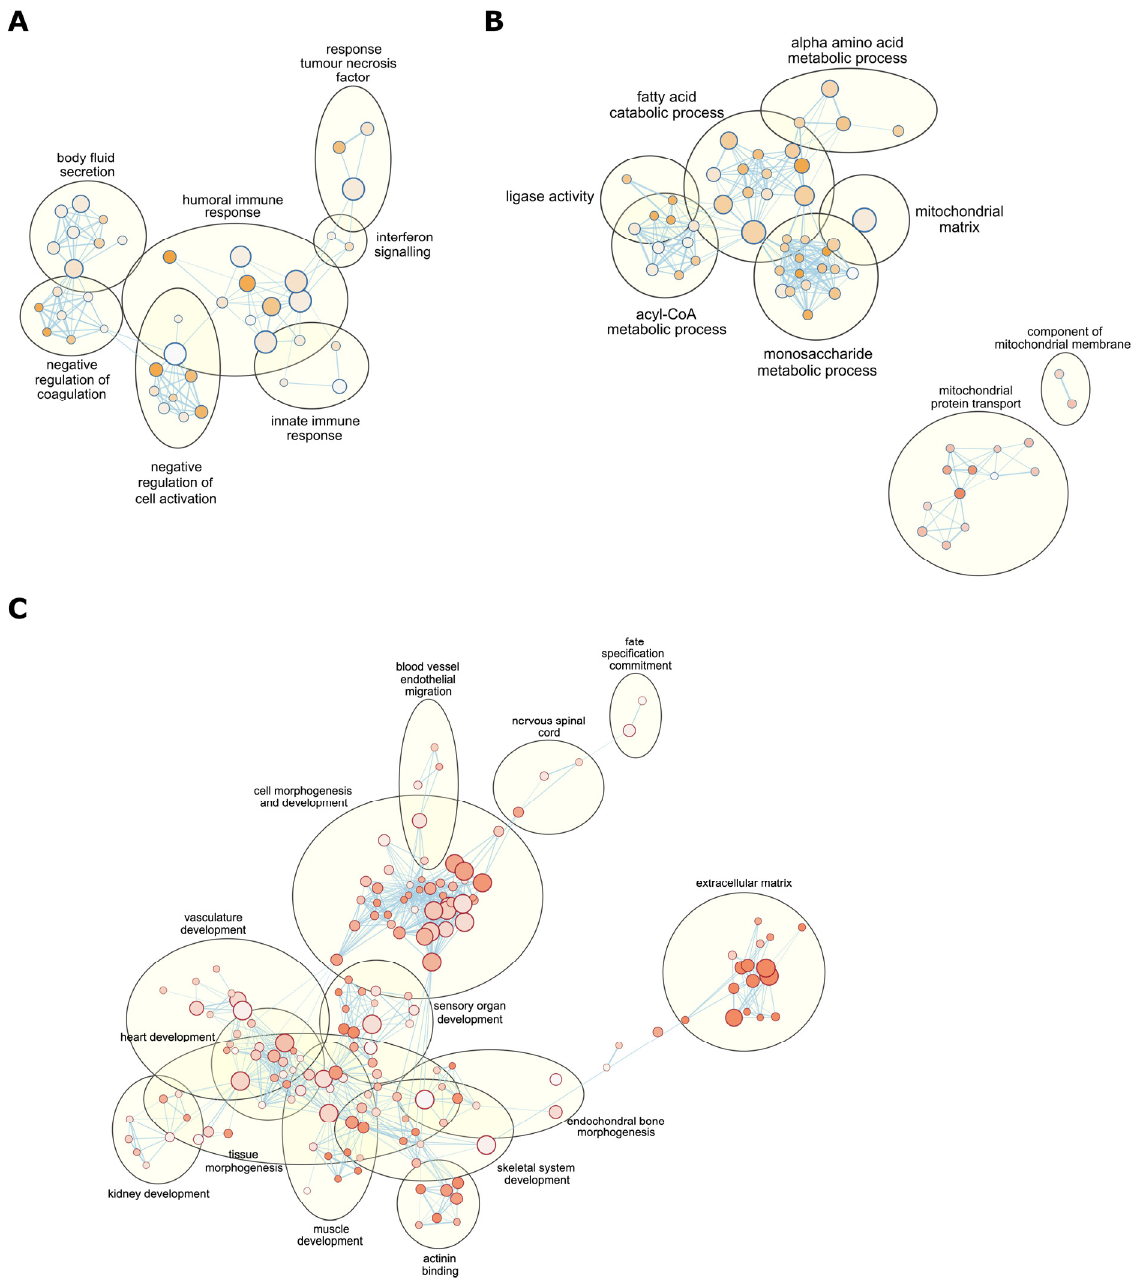
Figure 3. Functional pathway enrichment analysis displaying gene ontology (GO) biological process term networks. ( A ) The largest network associated with immune response, interferon signalling, and coagulation found in differentially expressed genes (DEGs) identified in brain tissue from mtDNA-supplemented and control pigs; ( B ) the largest network associated with fatty acid, acyl-CoA, monosaccharide metabolic processes (top) and mitochondrial protein transport related network (bottom) identified from heart DEGs between mtDNA-supplemented and control tissues; and ( C ) the largest network associated with morphogenesis and development for tissues and organs found in liver DEGs between mtDNA-supplemented and control tissues. GO terms with related function were grouped by Cytoscape auto-annotation function, and group annotation titles were given automatically or manually. Each circle represents an individual GO term, and the colour and size of a circle indicate the level of significance by pathway enrichment analysis and the number of genes associated with the GO term,